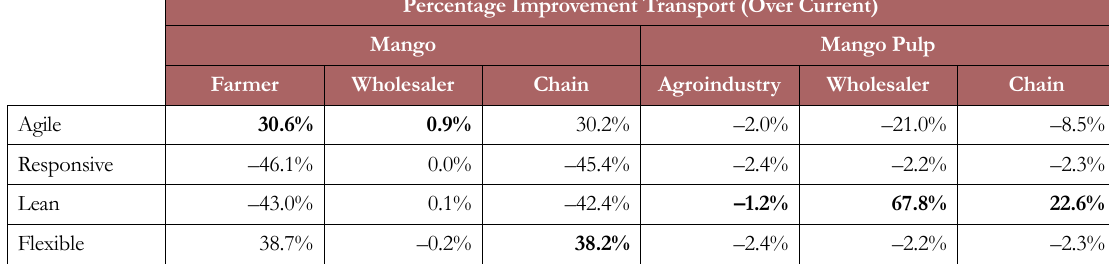
Table 8c. Percentage Change transport for